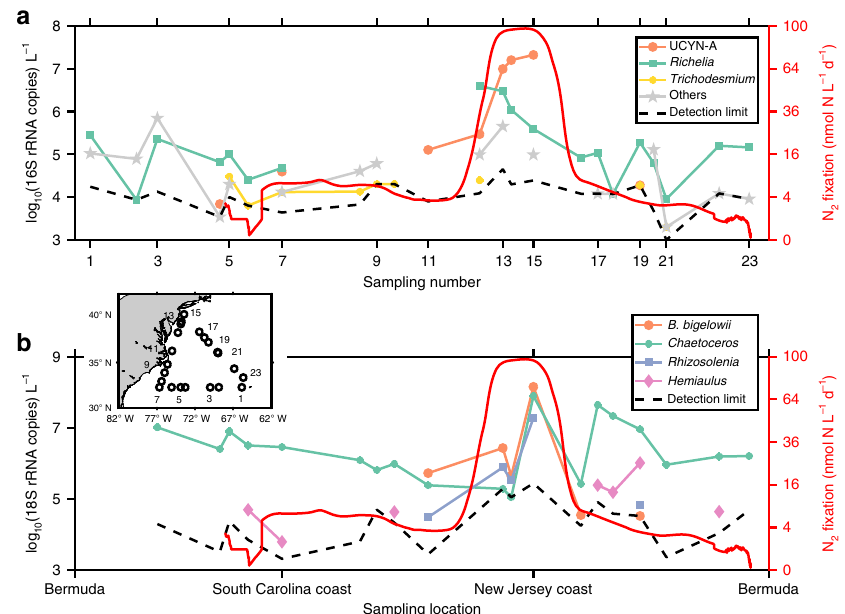
Fig. 2 Absolute rRNA gene abundances of various diazotrophs and their potential hosts in surface seawater collected during the 2015 cruise. The inset map shows the locations where molecular samples were collected. The distributions of diazotrophs ( a ) and hosts ( b ) are compared with surface daily N 2 fi xation rates (solid red line). Diazotrophs and hosts below detection limits at different sampling locations are not shown in the fi gure. “ Others ” in panel a includes diazotrophic proteobacteria belonging to Bradyrhizobium , Mesorhizobium , Novosphingbium , and Paenibacillus